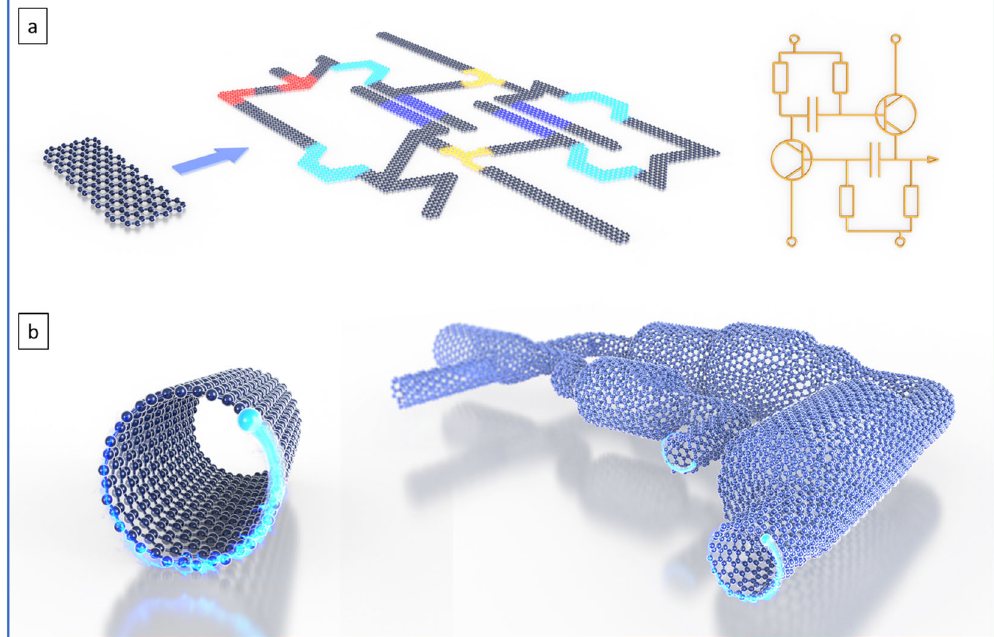
Fig. 2 Schematic of integrated electronic circuits from graphene ribbons and single-wall carbon nanotubes. a schematic and circuit from de fi ned graphene ribbons (inspired by ref. 53 ). b Schematic showing controlled growth of a single-walled carbon nanotube from a SAC (left) leading integrated single-walled carbon nanotube circuit components